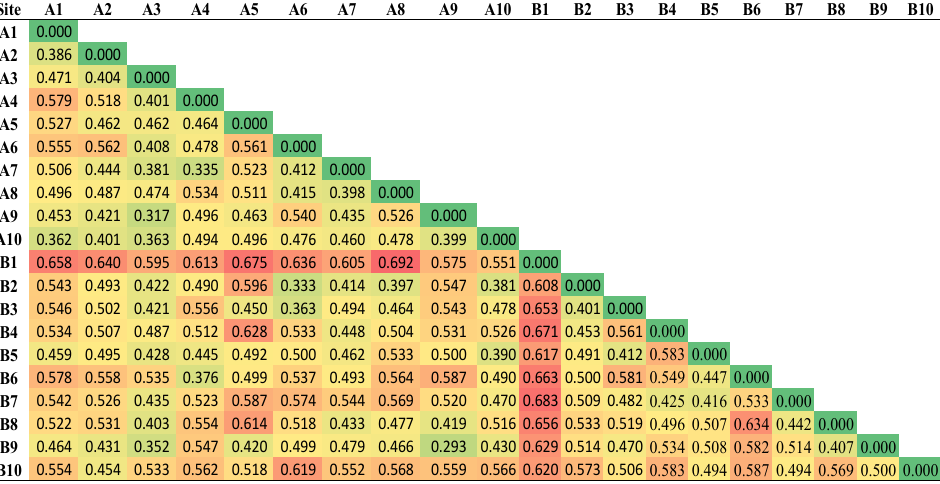
Figure 5. The dissimilarity matrix among the sampled sites of the seawater in both investigated areas.